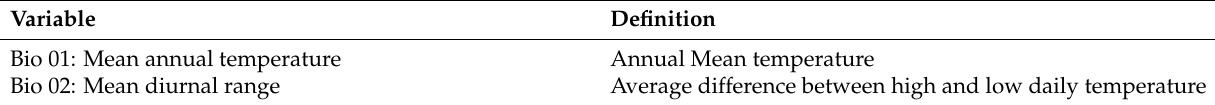
Table 1. Twenty-four variables incorporated in the Maxent and Random Forest models. Nineteen bioclimatic variables were derived from WorldClim and included historic and future predictions based on representative greenhouse concentration pathway scenario (RCP) 4.5 [3]. The U.S. Geological Survey (USGS) provides interpretation and calculations for each bioclimatic variable [47]. The